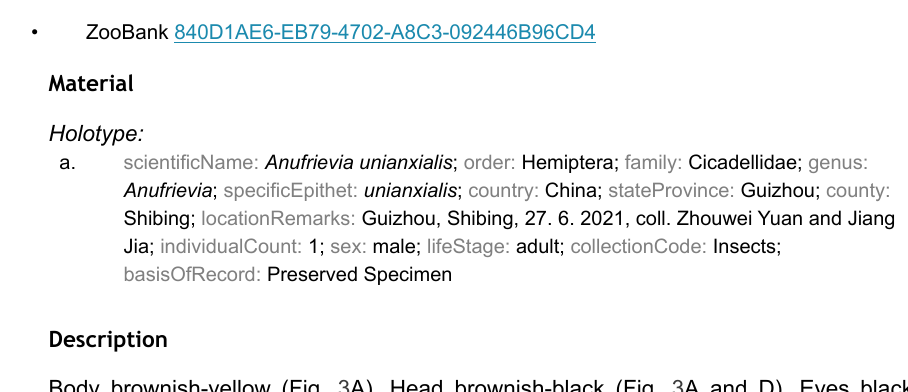
ZooBank 840D1AE6-EB79-4702-A8C3-092446B96CD4